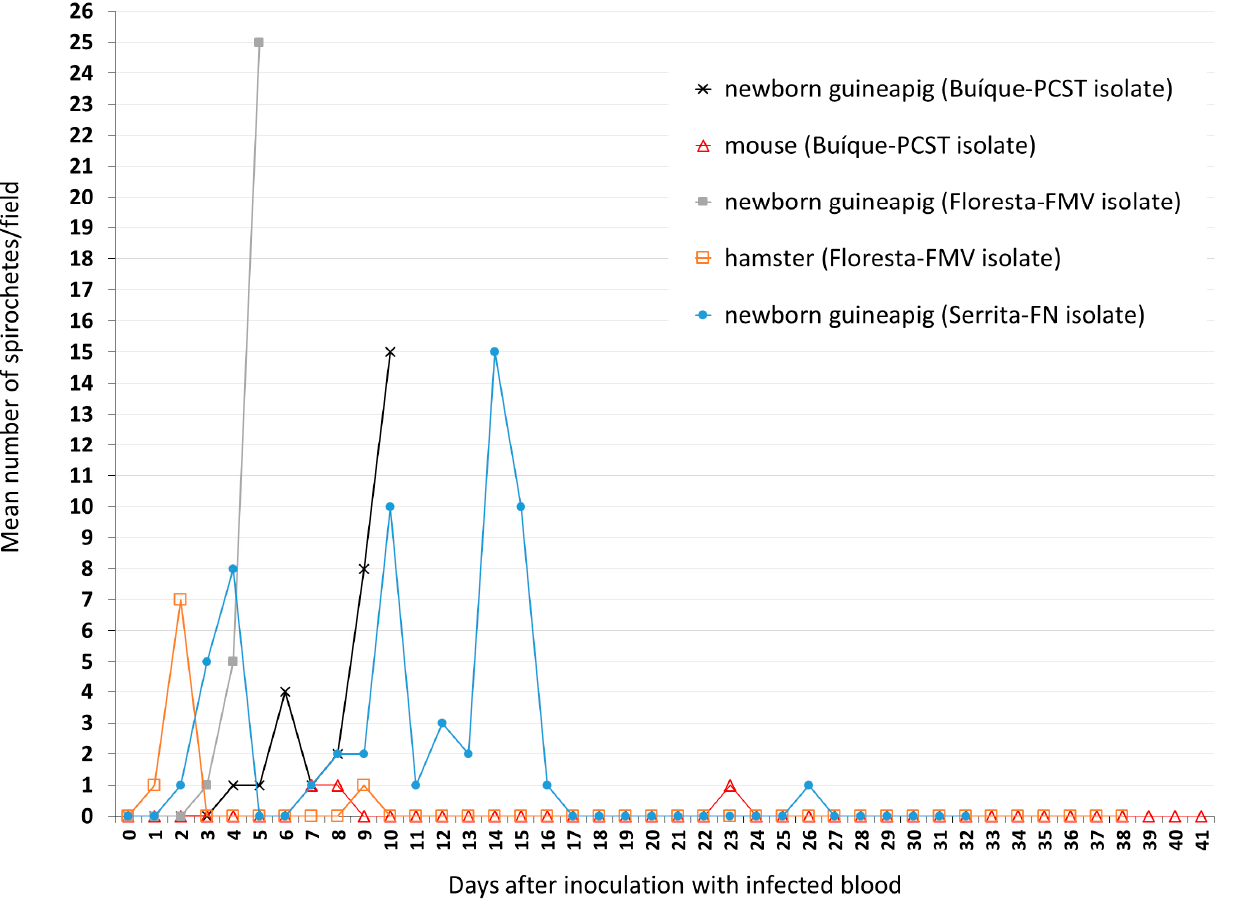
Figure 4. Results of dark-field examination of blood samples of newborn guinea pigs, hamster, and mouse according to the number of days after inoculation with blood samples that were collected from guinea pigs showing spirochetemia due to Borrelia sp. isolate Bu í que-PCST or Floresta-FMV or Serrita-FN. Values presented as the mean number of motile spirochetes per microscope field at 200x magnification in each sampled